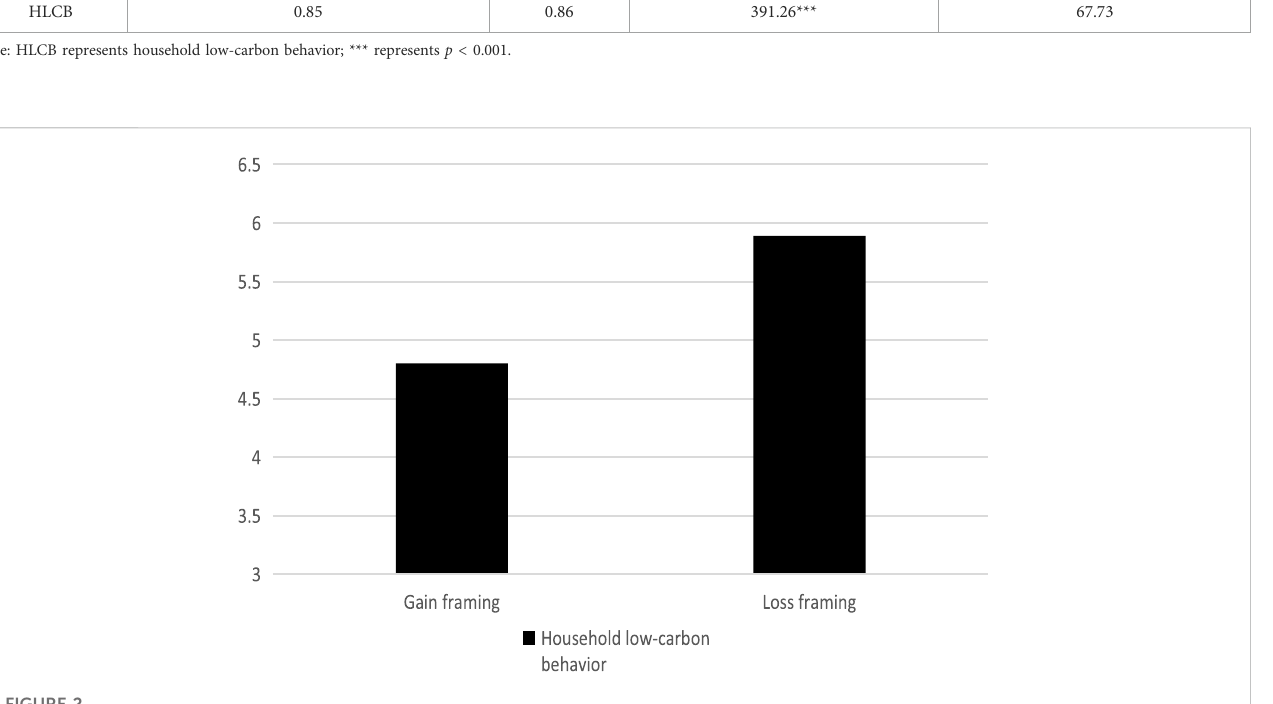
TABLE 1 Reliability and validity of a scale. Scale